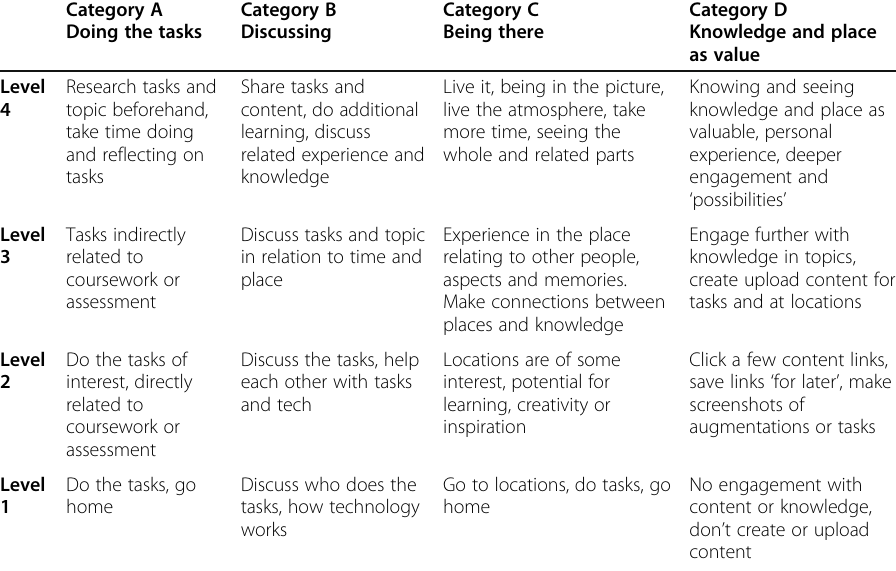
Table 2 Experience complexity of a smart learning